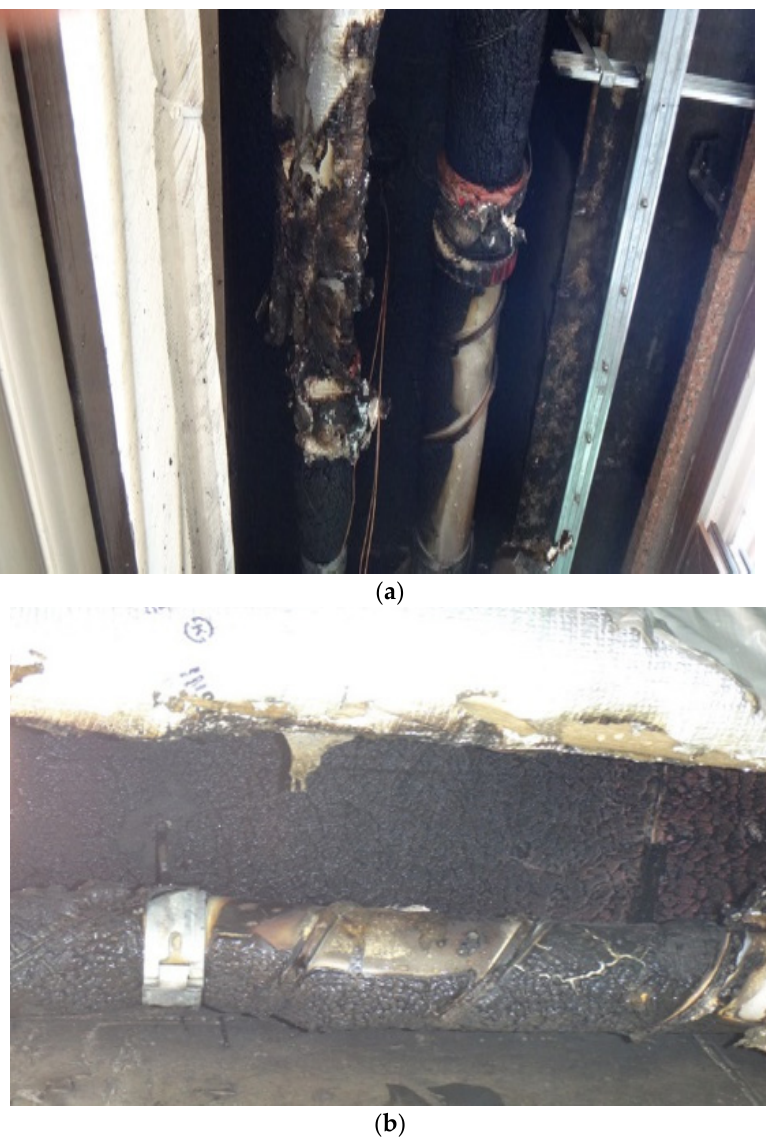
Figure 9. Fire caused by heat cables wrapped around water pipes at regular intervals. ( a ) Case 4—Fire site ➀ . ( b ) Case 4—Fire site ➁ .